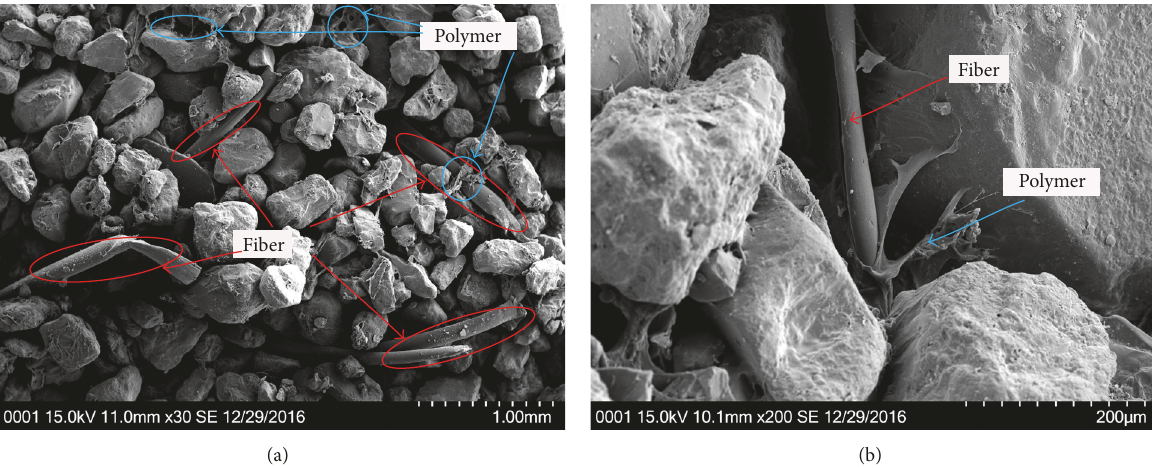
Figure 10: SEM images of sample reinforced with polymer-fiber: (a) 30 times magnification and (b) 200 times magnification.